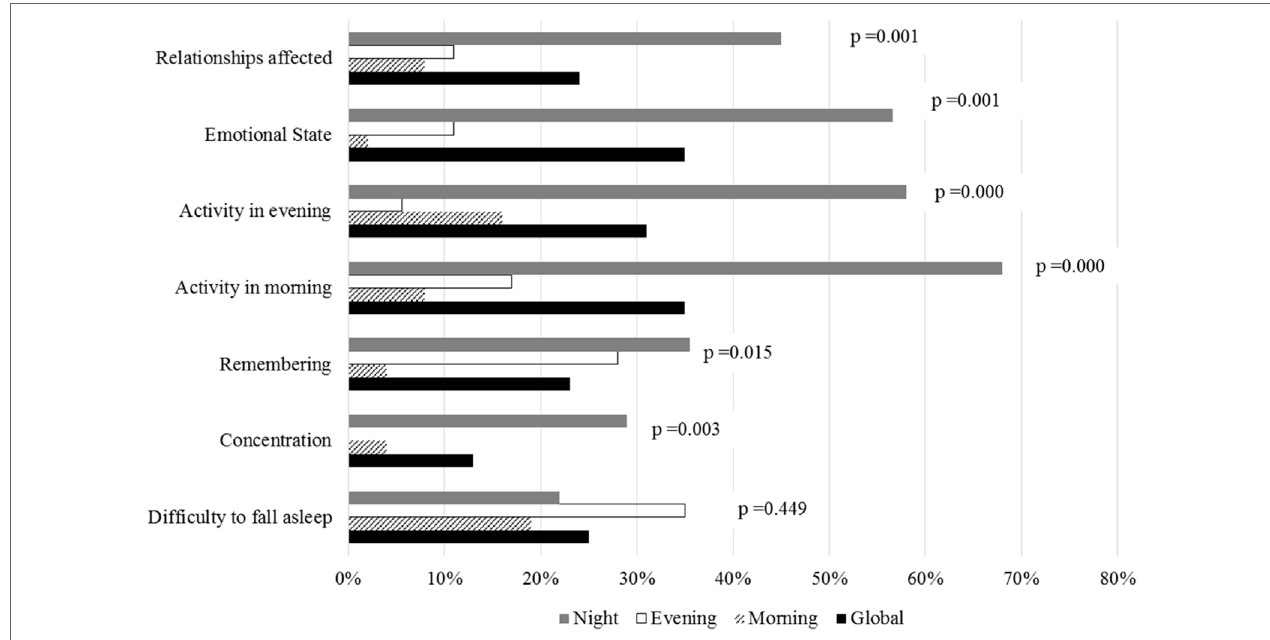
FigUre 3 | Comparison between work shifts of the impact of sleep disorders on daily life activities and relationships. Workers who had worse sleep quality according to Functional Outcomes of Sleep Questionnaire-10 also had a greater impact on their daily life activities.